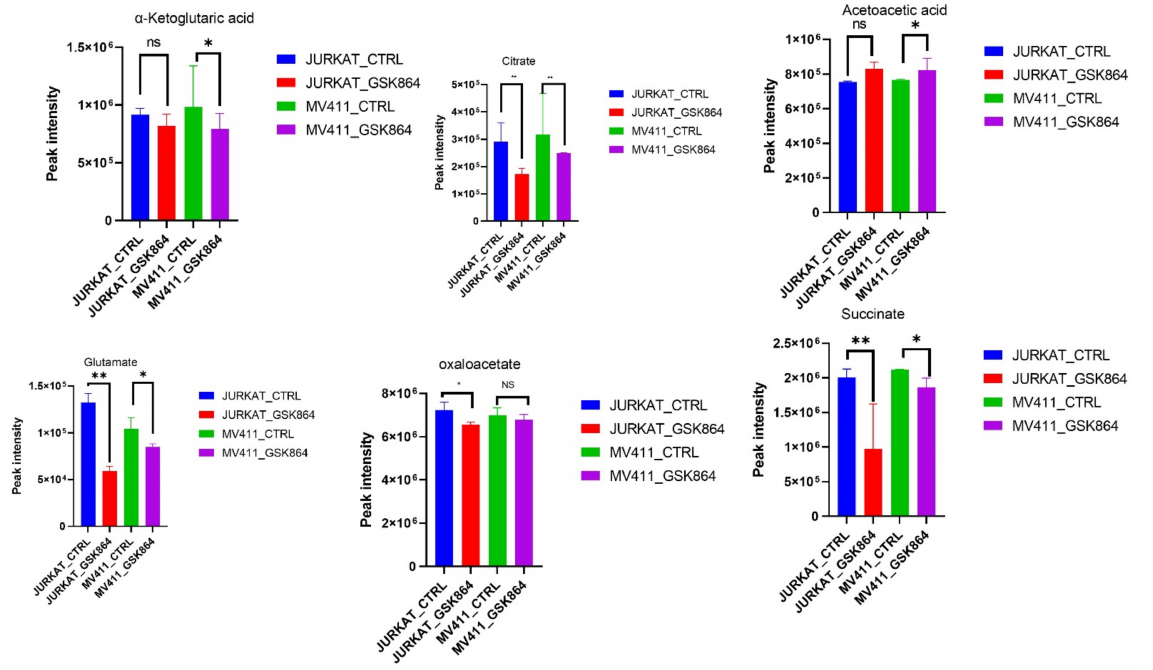
Figure 4. IDHi altered crucial TCA cycle pathways in leukemic cells. Quantitative levels of various metabolites involved in TCA cycle pathways of control and GSK864-treated cells, * p < 0.01. ** p <